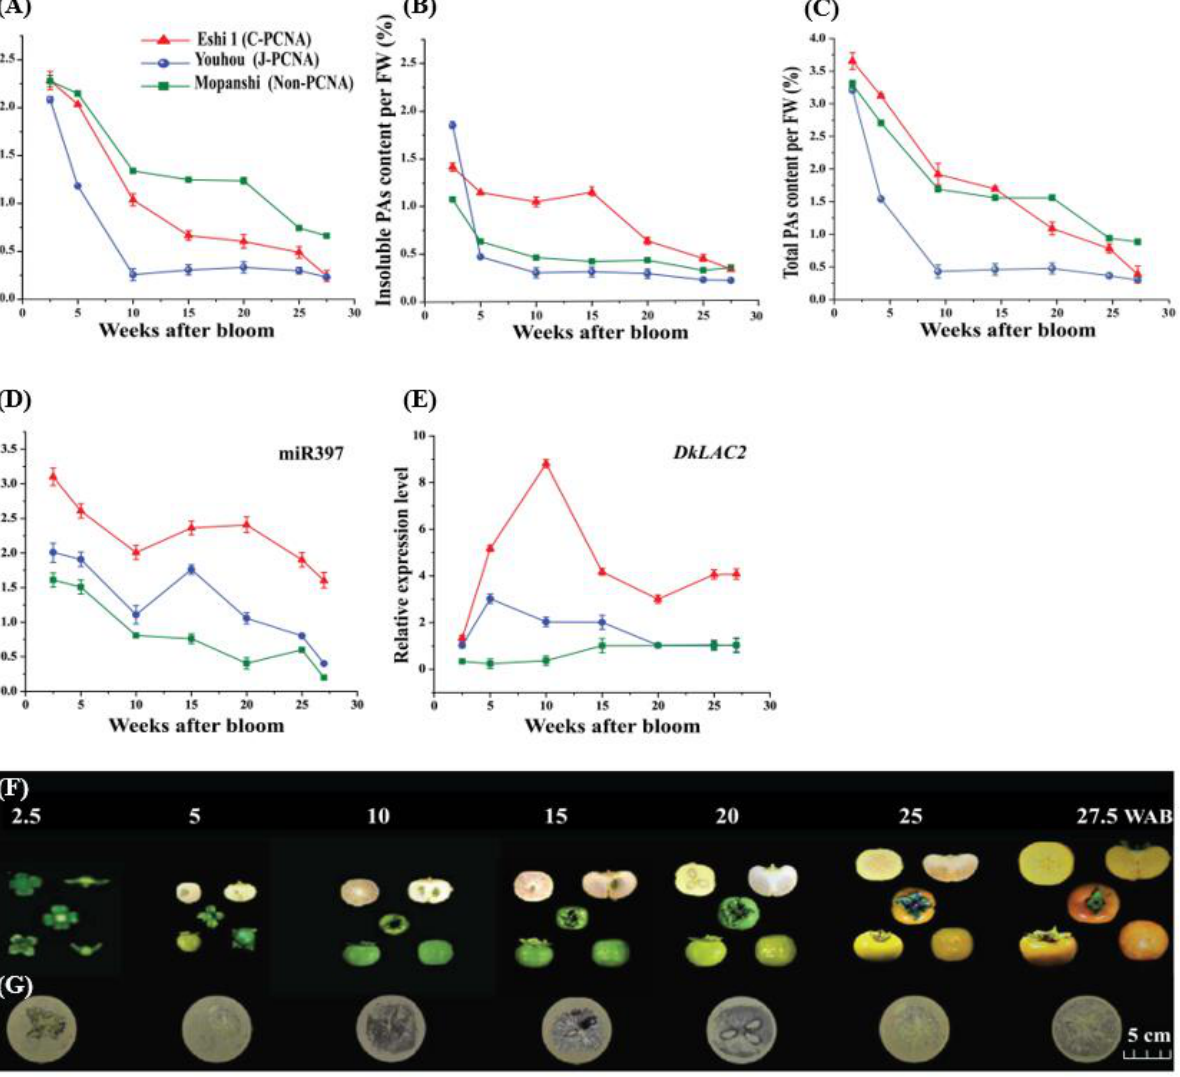
Figure 1. Proanthocyanidins and DkmiR397 with DkLAC2 variation in three persimmon genotypes fruits. ( A ) Changes in soluble PAs content. ( B ) Changes in insoluble PAs content. ( C ) Changes in total PAs content. ( D ) Expression variation in DkmiR397. ( E ) Expression variation in DkLAC2 . The ‘ Eshi 1 ’ (C-PCNA) persimmon fruits from 2.5 WAB to 27.5 WAB were used for determining the PAs content based on the tannin printing technique ( F , G ). Error bars indicate SE from three biological replicates ( n = 3).